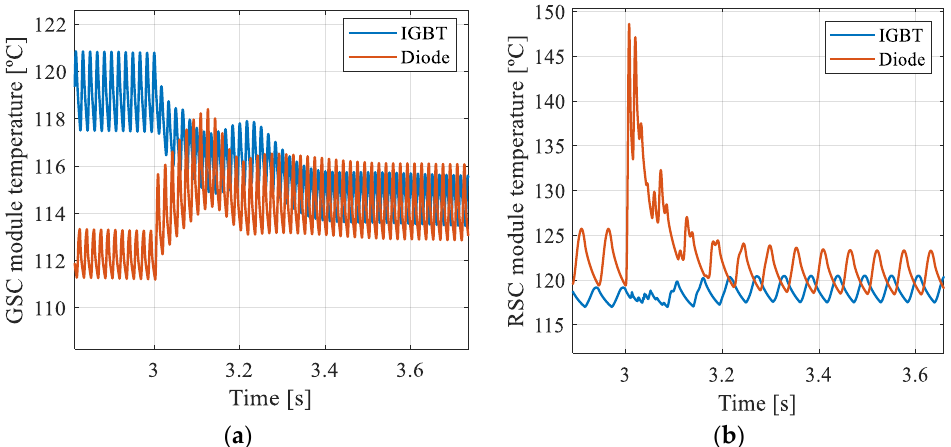
Figure 11. Junction temperature of the power module during a balanced voltage sag: ( a ) GSC and ( b ) RSC.